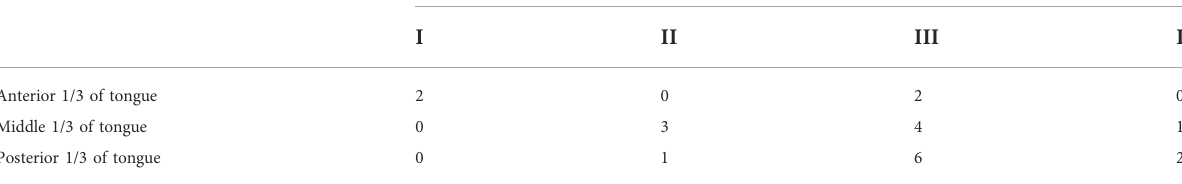
TABLE 3 Distribution of the metastatic LNs in tongue carcinoma